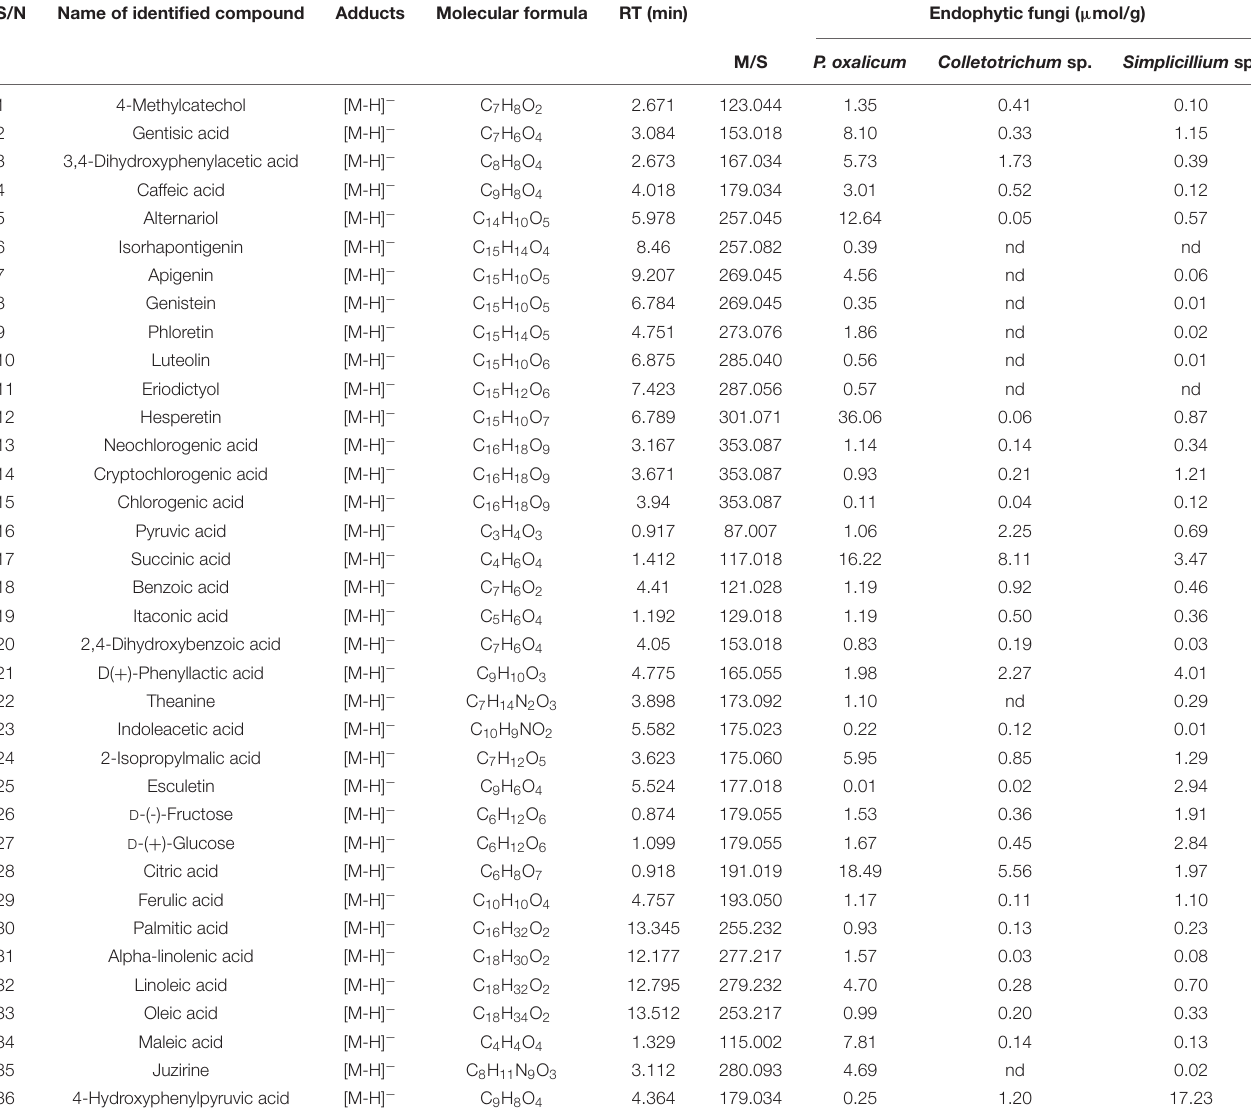
TABLE 6 | The identification of the chemical composition of endophytic fungal extracts by LC-MS analysis.